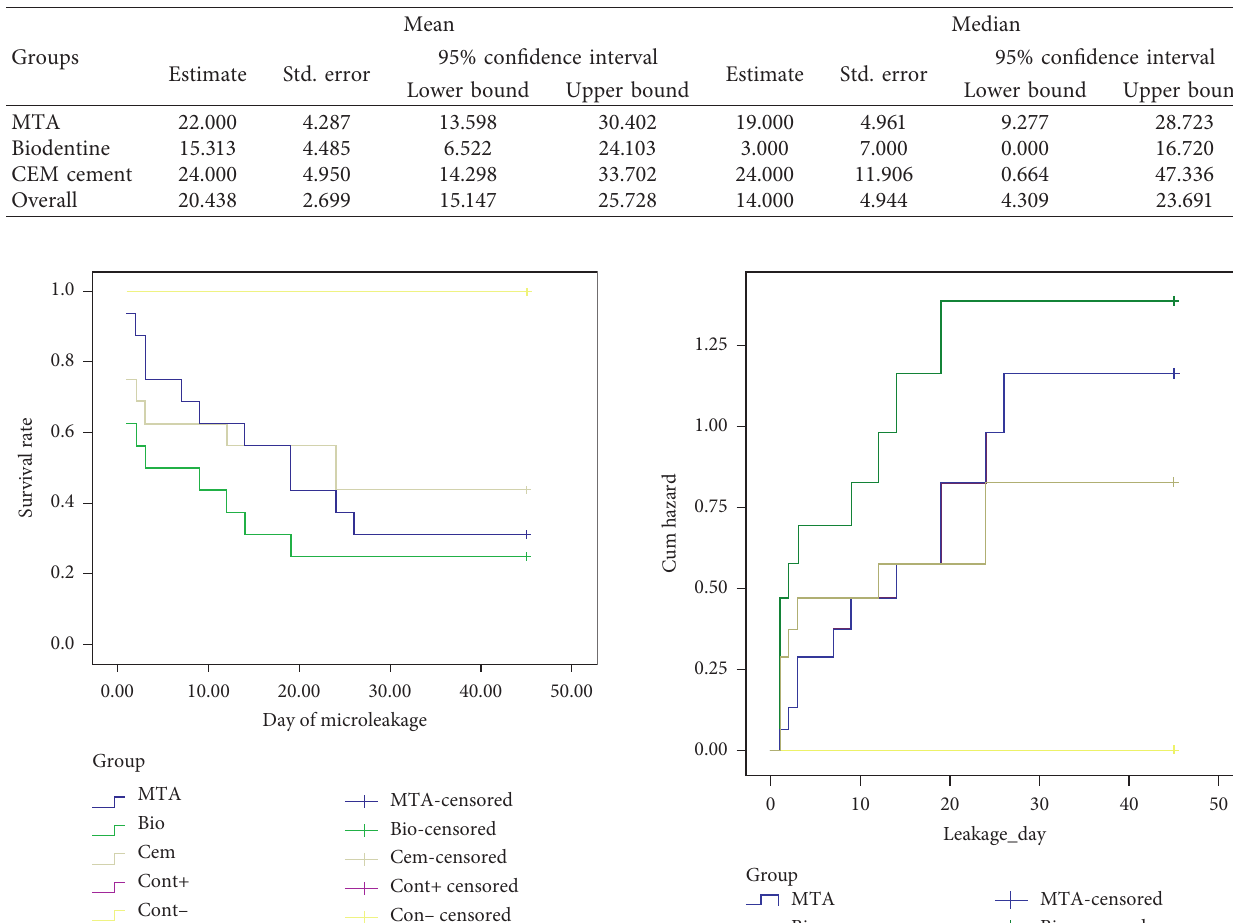
Table 1: Mean and median survival time of microleakage.